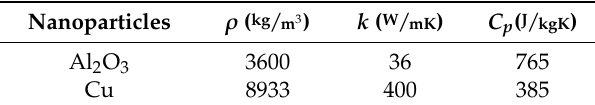
Table 1. Nanoparticle properties.